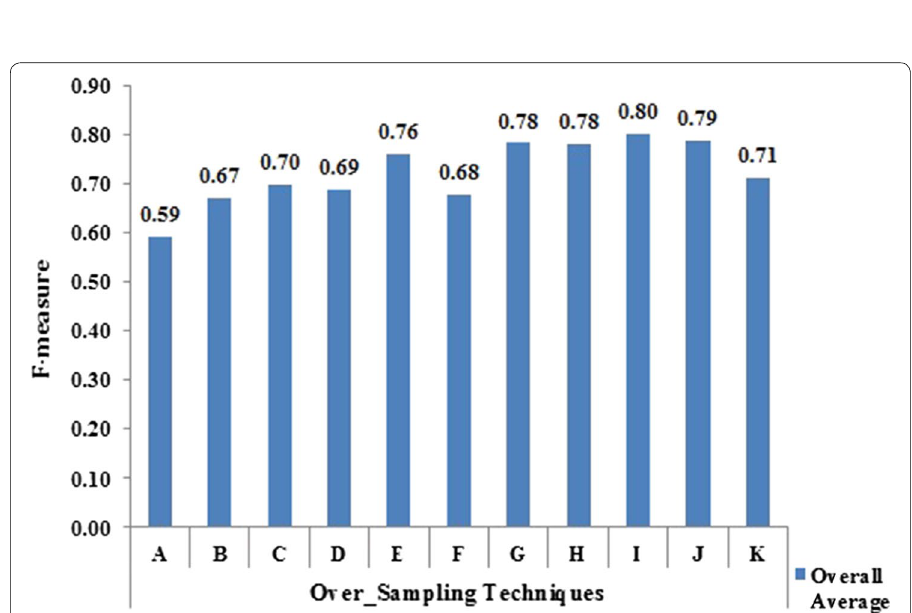
Fig. 5 Average F-measure values for multi-class semi-structured/un-structured data sets (LVH) with cross- validation 10 and K NN = =